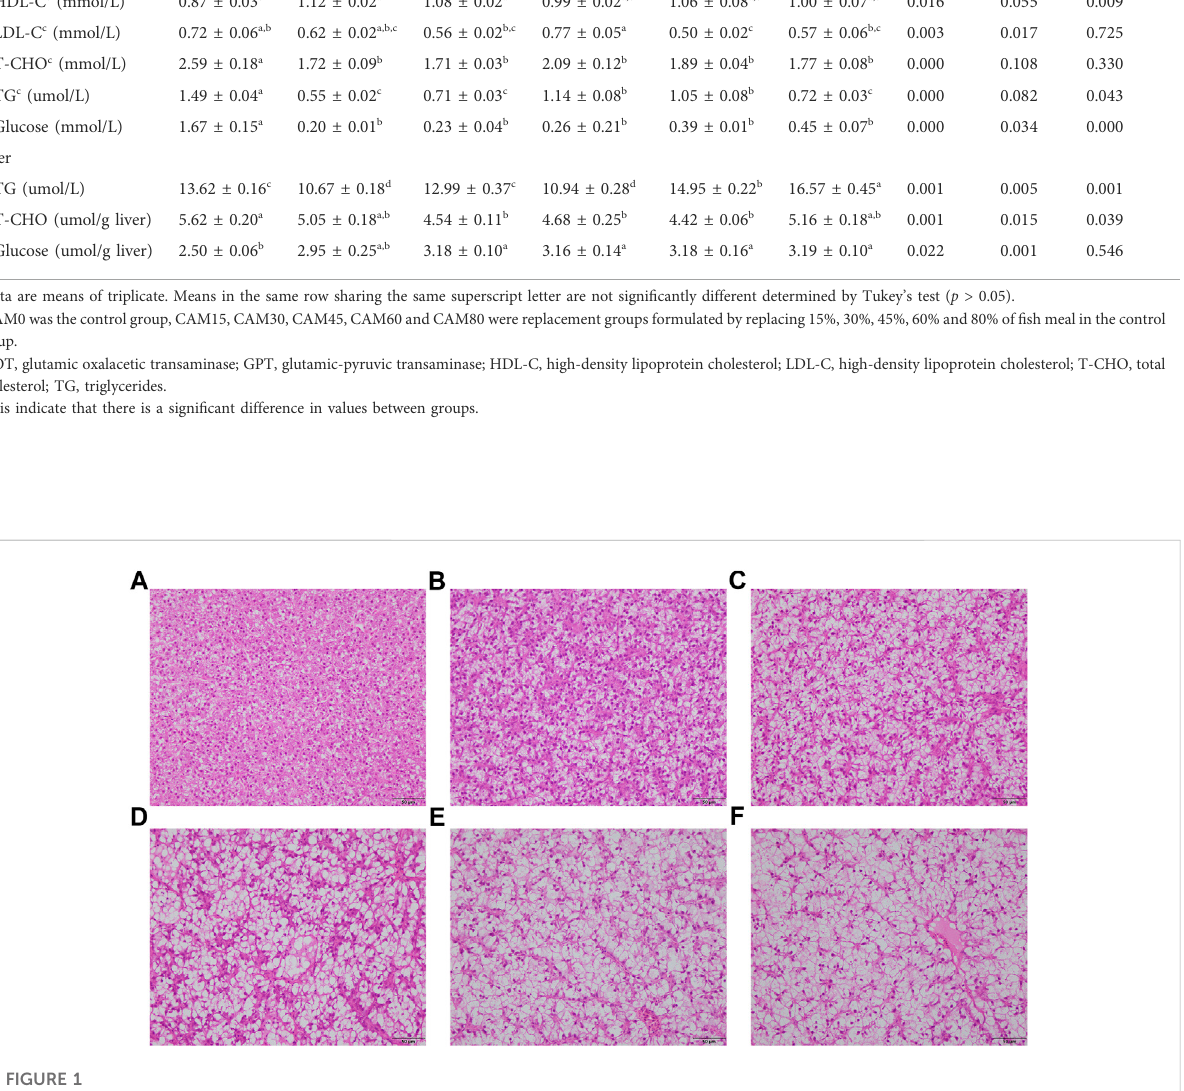
1 ( pept1 ), cationic amino acid transporter ( cat2 ), B 0 -type amino acid transporter 1 ( b 0 at1 ), proton-coupled amino acid transporter 1 ( pat1 ), system ASC amino acid transporter-2 ( asct2 ) and T-type